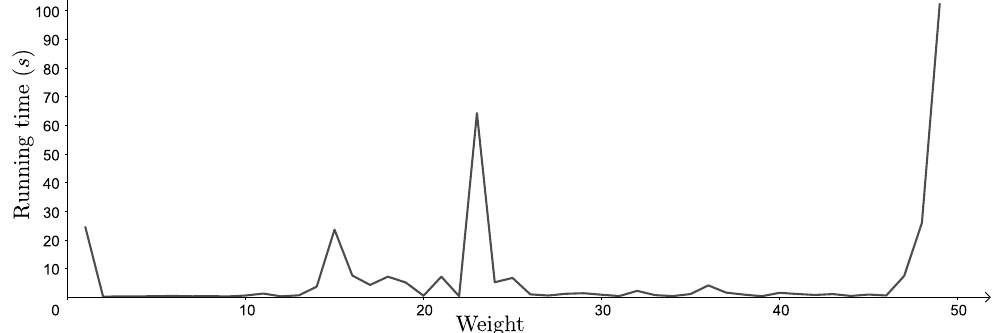
Figure 11. Running time (in seconds) required for computing the cardinality of the set V Q ( I PI ( L , L )) , for random partial Latin squares L ∈ L 7; m , with 1 ≤ m ≤